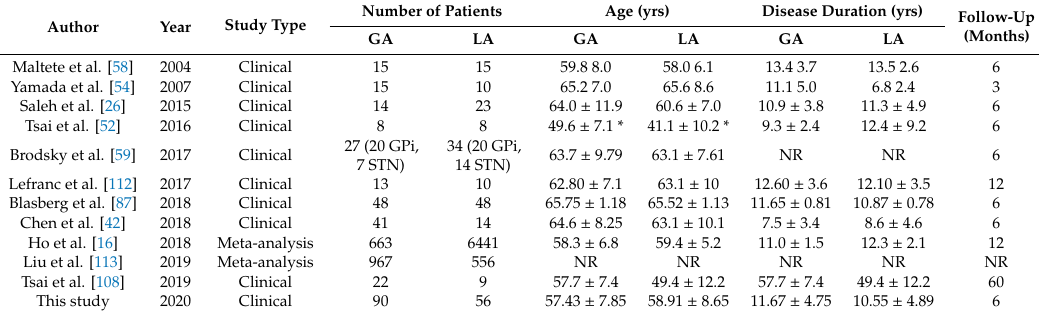
Table 2. Summary data of published literature comparing clinical outcome e ff ect of after subthalamic nucleusdeepbrainstimulationundergeneralanesthesiaandlocalanesthesiainpatientswithParkinson’s disease: Baseline patient